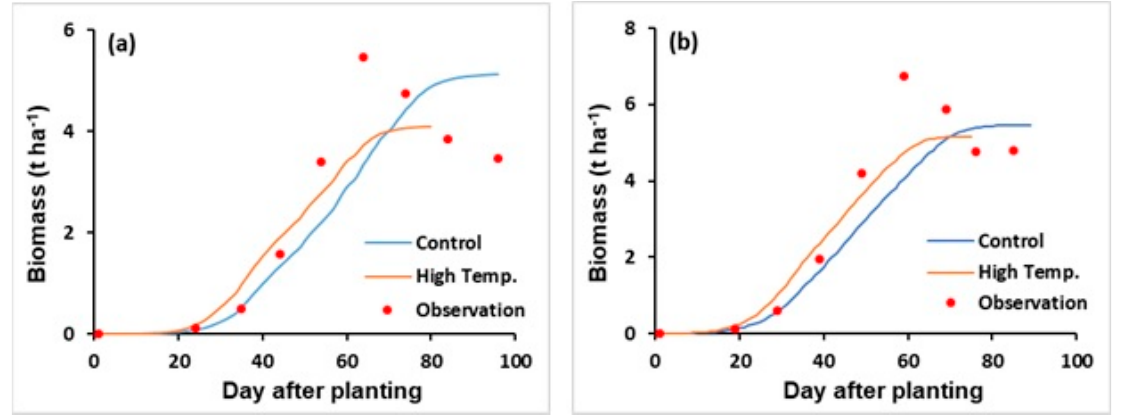
Figure 7. Total aboveground biomass under di ff erent atmospheric temperature for the control and high temperature, and observed total biomass from the experiment site.